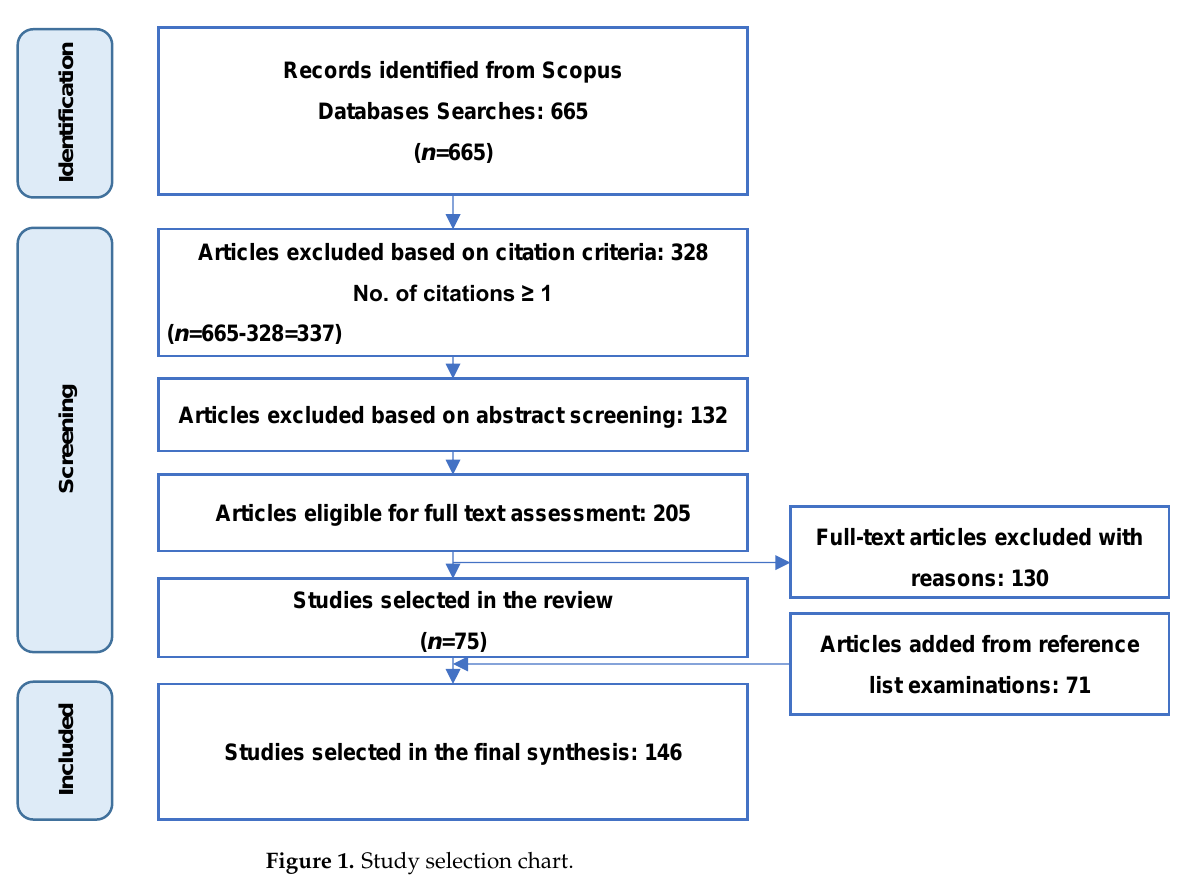
Figure 1. Study selection chart.